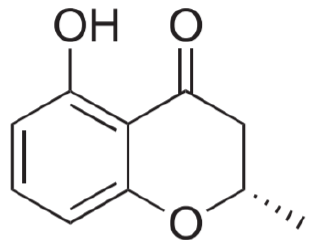
Figure 2. Molecular structure of C2 ; 5-hydroxy-2-methyl-chroman-4-one (HMC).